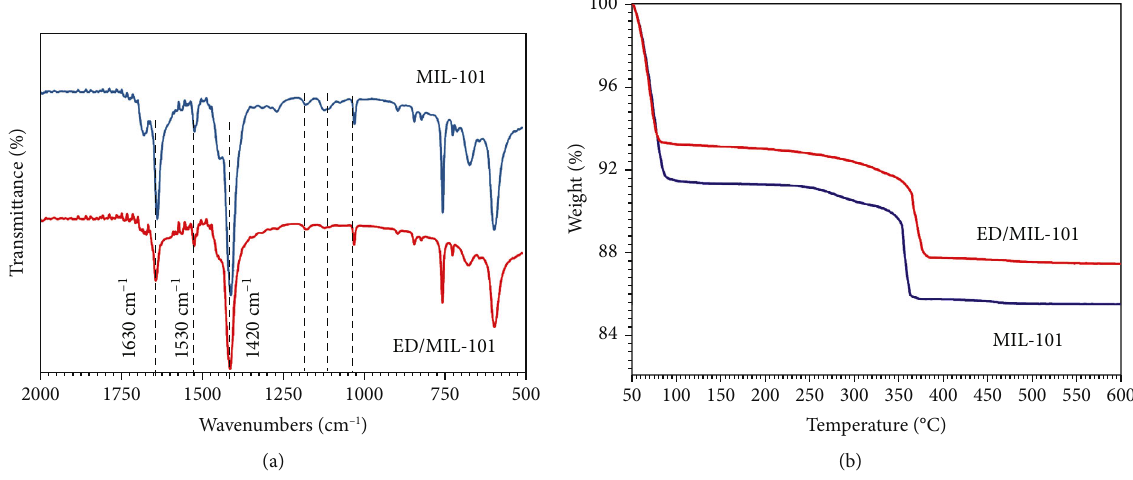
Figure 4: (a) FT-IR spectrograms of MIL-101 and etched MIL-101. (b) The TGA curves of MIL-101 and etched MIL-101. Table 1: The speci fi c area and pore volume of etched MIL-101.